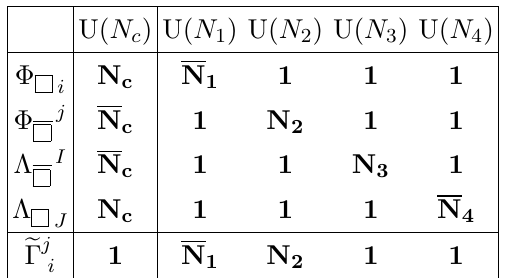
Table 2 . Matter (cid:12)elds in 0 d